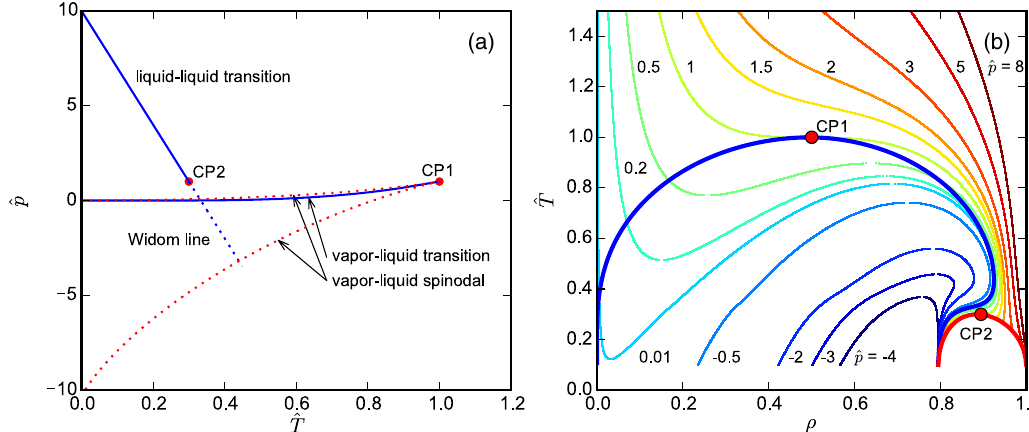
ˆ T ¼ T=T ˆ p ¼ p=p ρ is the density. (a) Pressure-temperature diagram. FIG. 1. Phase diagram for a polyamorphic lattice gas: c 1 and c 1 , The blue curves are either vapor-liquid or liquid-liquid transitions; CP1 and CP2 are the vapor-liquid and liquid-liquid critical points assigned (as an example) to be at the same isobar. The red dotted curves are the liquid and vapor branches of liquid-vapor spinodal and the blue dotted line is the Widom line. (b) Temperature-density diagram. The thick blue and thick red curves are the vapor-liquid and liquid-liquid coexistence, respectively. The multicolor curves are selected isobars.